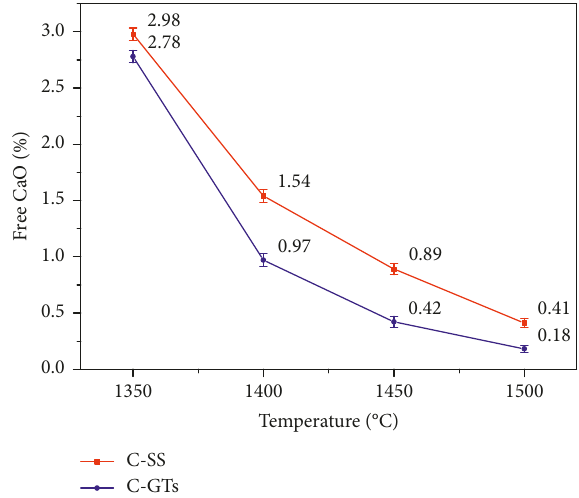
Figure 4: f-CaO contents of C-SS and C-GTs at different temperatures.